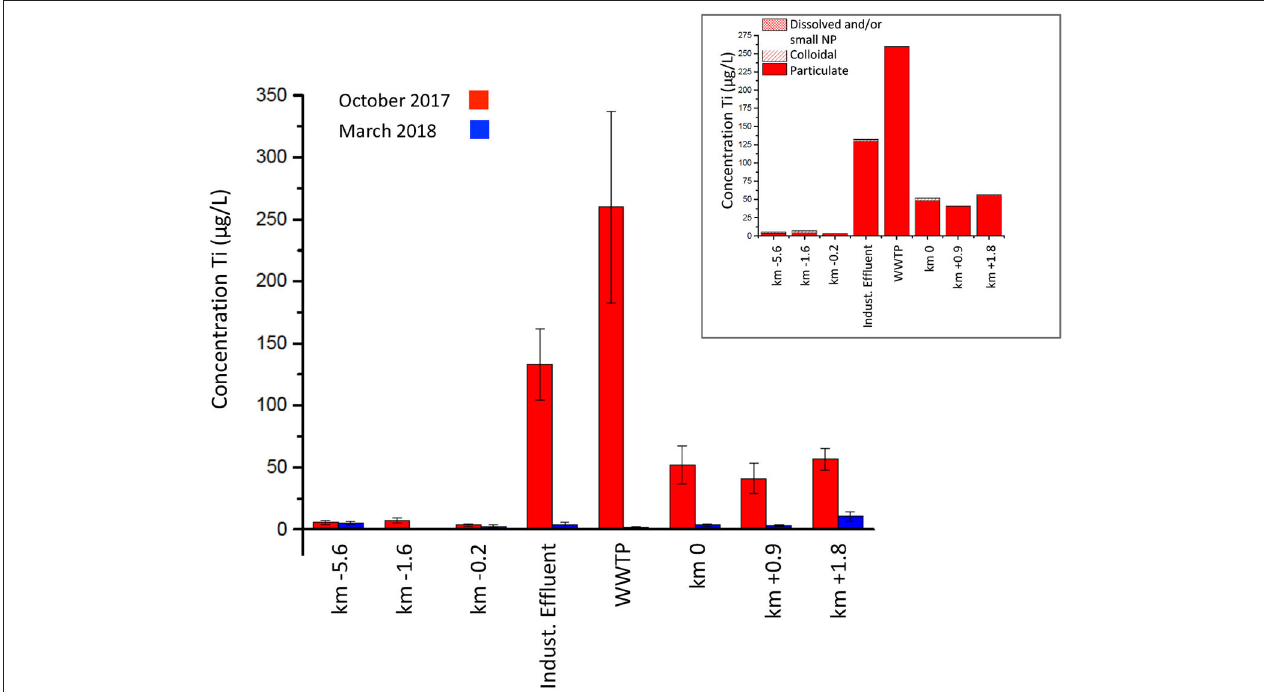
FIGURE 4 | Total Ti concentrations ( µ g/L) in raw surface waters. Inset: Ti concentrations ( µ g/L) measured in dissolved and/or nanoparticulate (NP) ( < 0.02 µ m) fraction and Ti concentrations ( µ g/L) calculated for colloidal (0.02–0.20 µ m) and particulate ( > 0.20 µ m) fractions for October 2017 samples. Error bars represent replicate sample digestions of the same sample ( n =